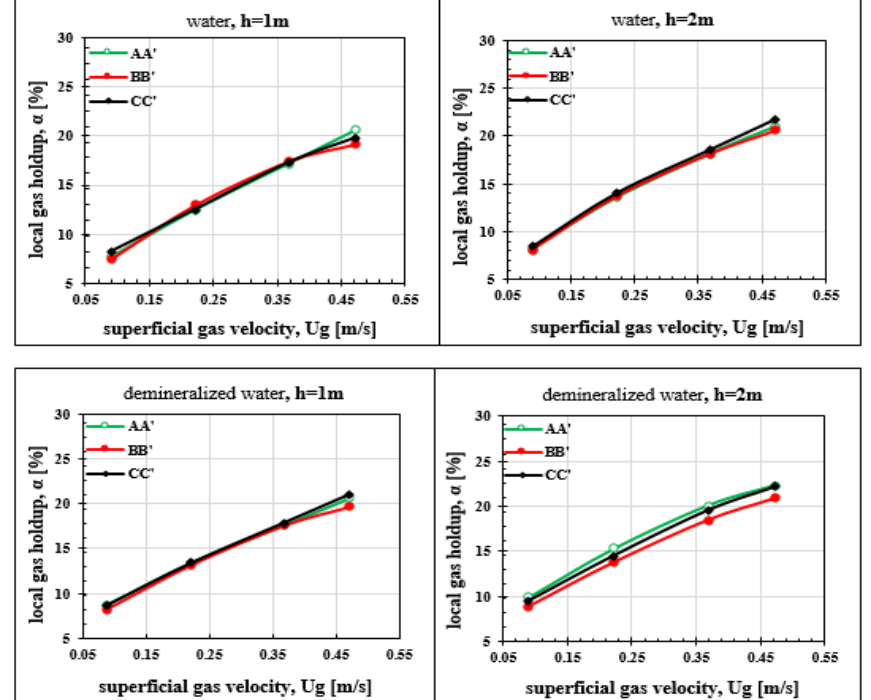
Figure 13. Relationship between local gas holdup and global gas velocity.